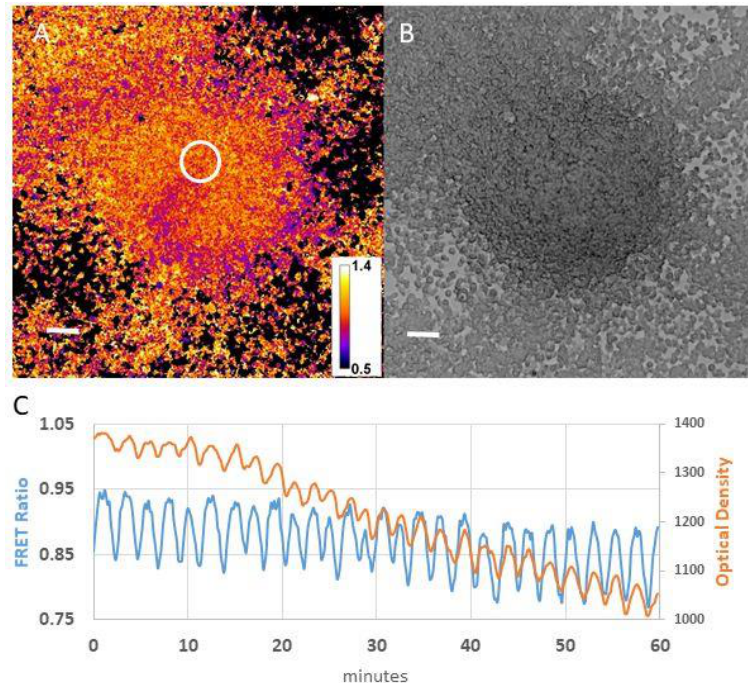
Figure 4. Comparison of cAMP and optical density waves during late aggregation. ( A ) Image showing the dynamics of cAMP waves in a streaming aggregate. Intracellular cAMP variations were measured using a cAMP specific FRET sensor. The sensor is based on the mammalian EPAC cAMP binding protein, and cAMP variations are measured as donor-acceptor emission ratios [77]. ( B ) Optical density image of the same aggregate as shown in ( A ). ( C ) FRET ratio and optical density changes as functions of time measured in the circle region shown in ( A